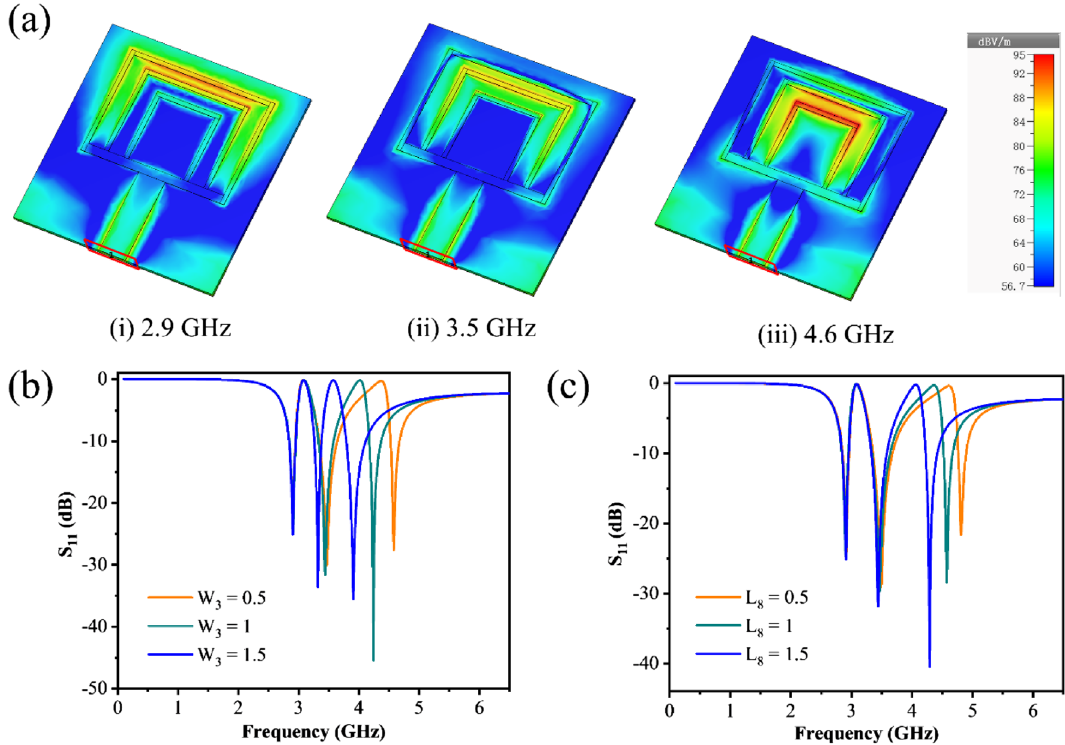
Figure 4. ( a ) Electric field distribution of the triple ring antenna at different resonant frequencies, and simulated responses of the proposed triple ring antenna for different values ( b ) the width of W 3 , ( c ) the height of L 8